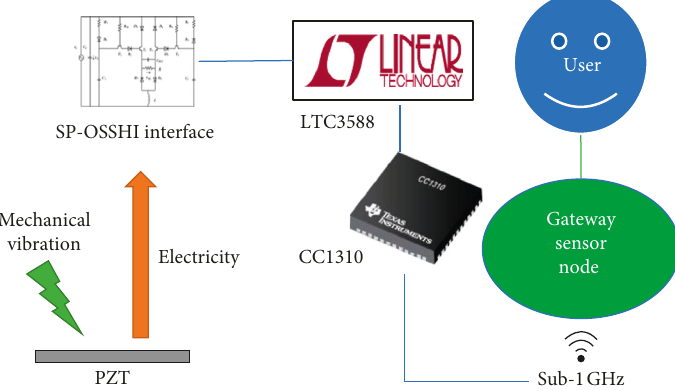
Figure 14: Self-powered WSN node.